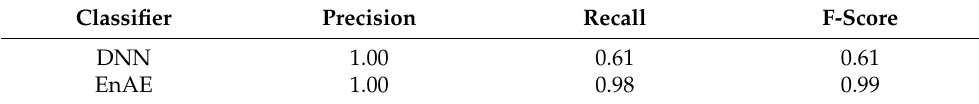
Table 12. Results of assessing the quality of the classification of adversarial examples.